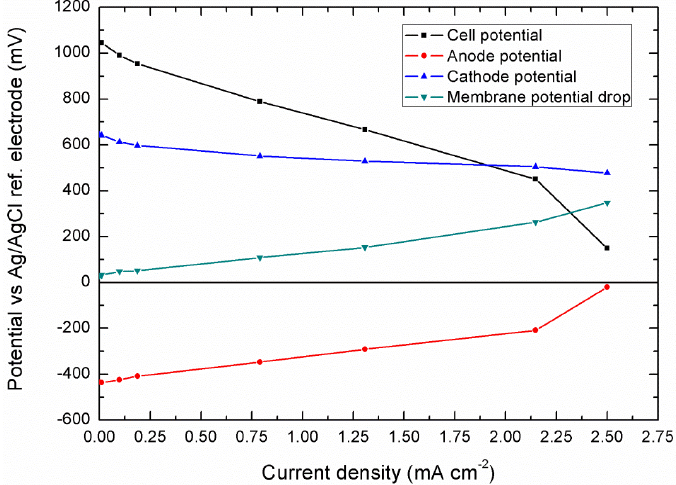
Figure 5. Potential diagram for the MFC device at steady state.